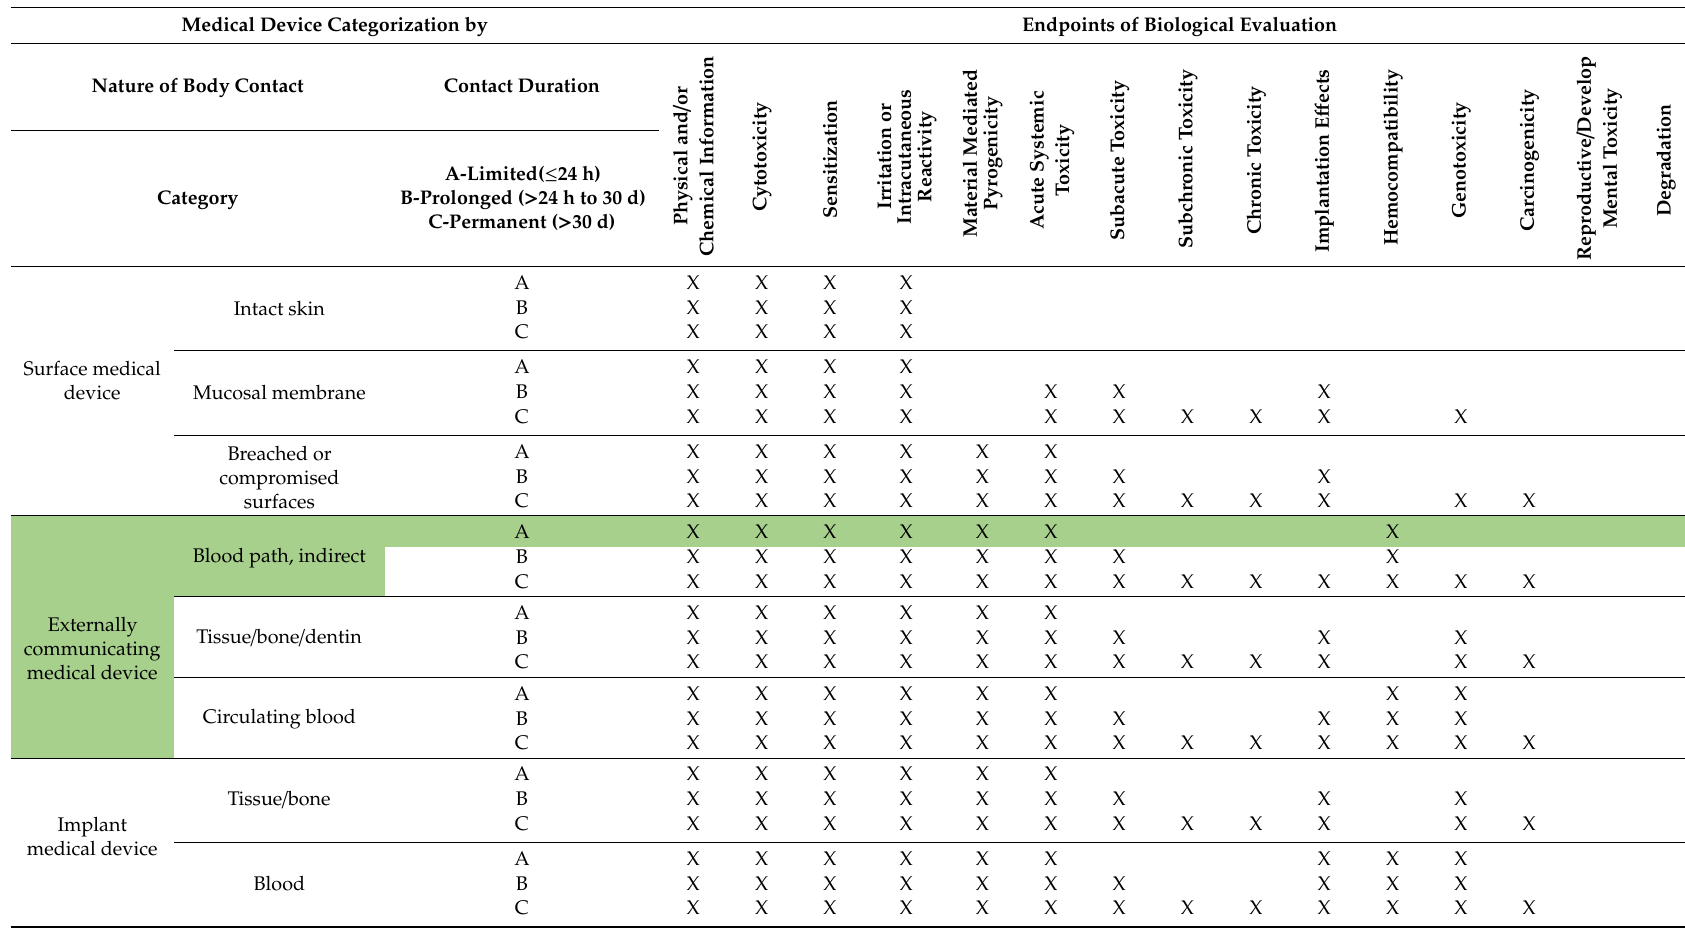
Table 3. Medical device categorization